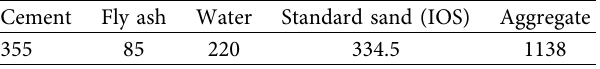
Table 5: C30 concrete mixed ratio